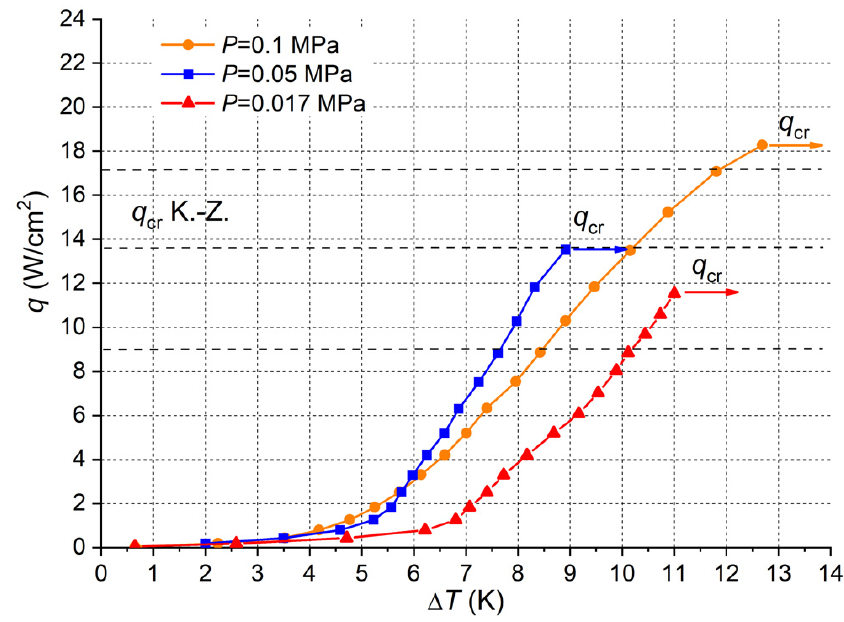
Figure 3. Boiling curves for the smooth heater at different pressures. The boiling curves, as well as values of critical heat fluxes, for the samples modified by microarc oxidation at all studied pressures are shown in Figure 4. For sample No. 1, there is no pronounced break in the curve at atmospheric pressure, which is due, as it will be shown below, to boiling with a high nucleation site density even at very low heat fluxes (less than 0.4 W/cm 2 ). In addition, for this sample, the critical heat fluxes obtained during the experiments almost coincide with the CHF for the uncoated sample both at atmospheric and low pressures and are q cr = (17.5; 13.4; 11.2) W/cm 2 , respectively. For sample No. 2, we can see a slight decrease by 15% (15.4 W/cm 2 ) in the critical heat flux compared with the uncoated heater at atmospheric pressure, but there is almost no effect of the coating on the CHF (12.7 and 11.6 W/cm 2 ) at pressures of 0.05 and 0.017 MPa. A decrease in pressure during experiments leads to degradation in the heat transfer on both modified heaters and a shift in the transition from natural convection to developed nucleate boiling to the region of higher temperature differences. The maximum decrease in heat transfer at 0.05 MPa was 30% for both test samples, and it was 55% and 45% for the samples No. 1 and No. 2, respectively, at 0.017